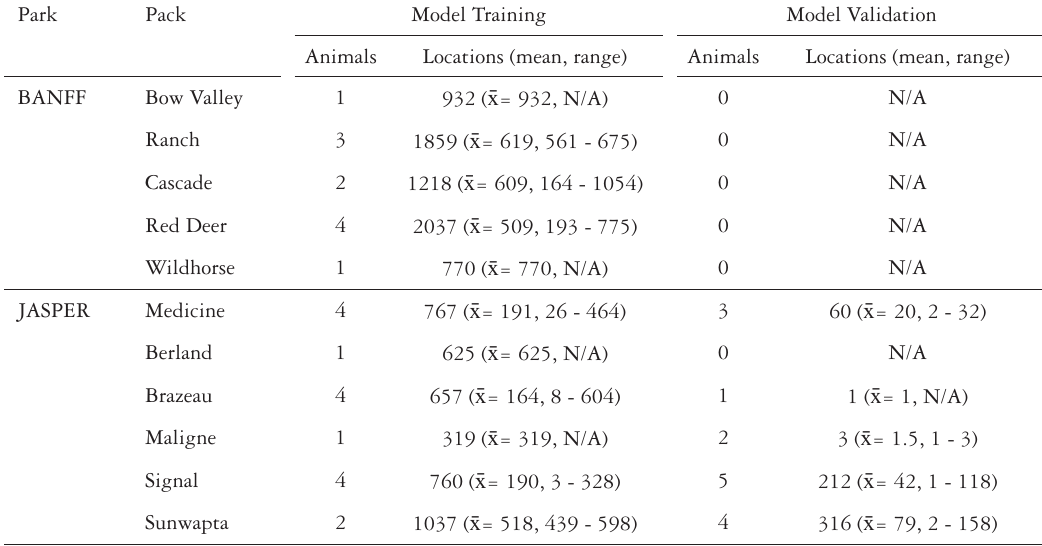
S-table 2. Number of animals from each wolf pack monitored during summer in Banff and Jasper National Parks, and total number of locations used in summer model development and validation 2002 -